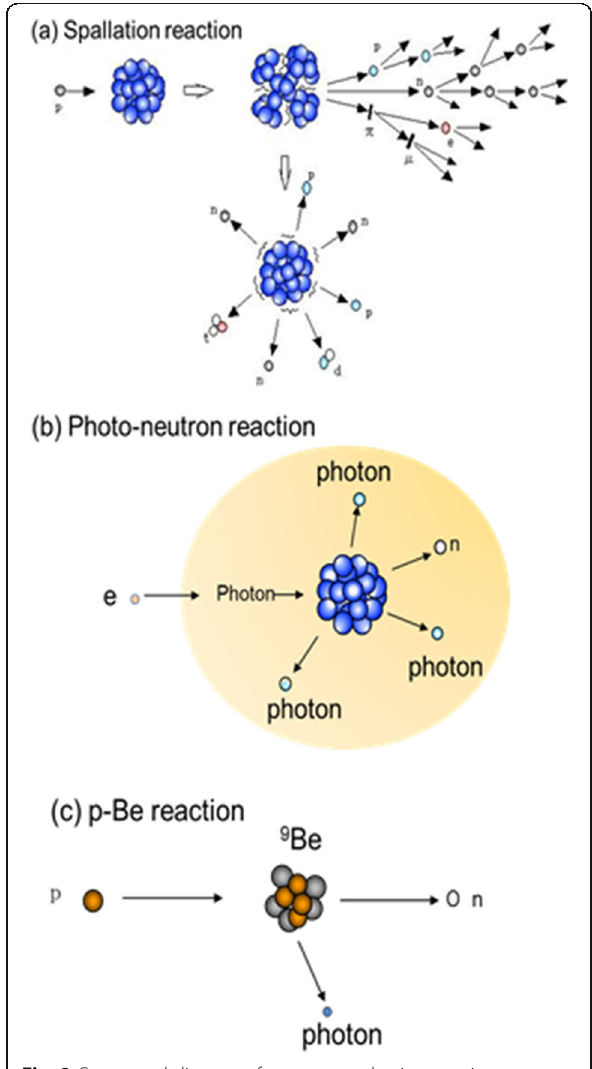
Fig. 2 Conceptual diagram of neutron production reactions. a Spallation reaction, b photo-neutron reaction, and c p-Be